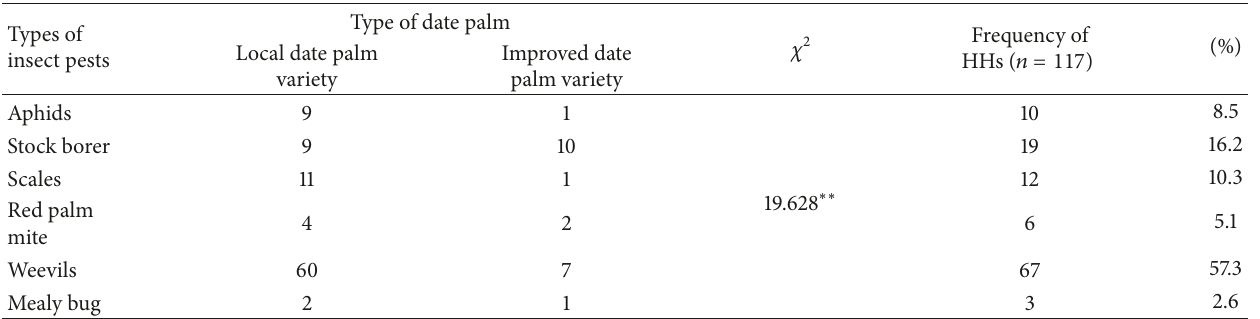
Figure 6: The process of hand pollination of date palm in the study area (photos taken during field supervision, 2016). Table 5: Common insect pests by date palm type in the study areas.